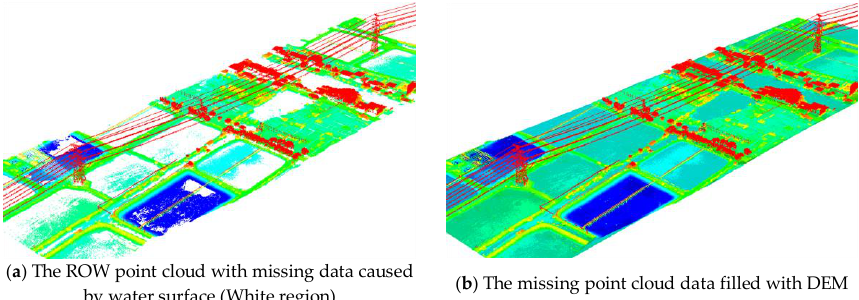
Figure 6. Painting the the missing laser point cloud data with DEM.